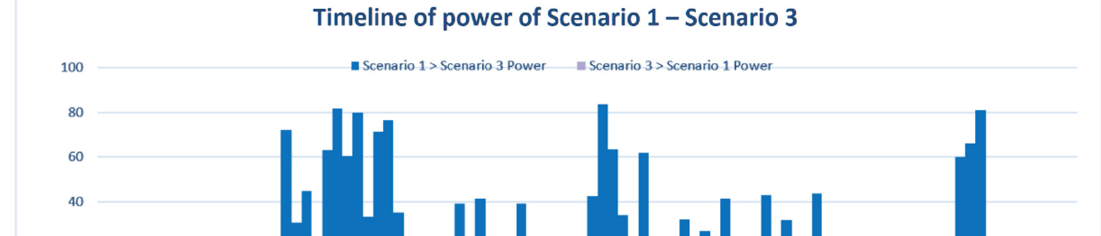
Figure 9. Scenario 1 vs. Scenario 2.